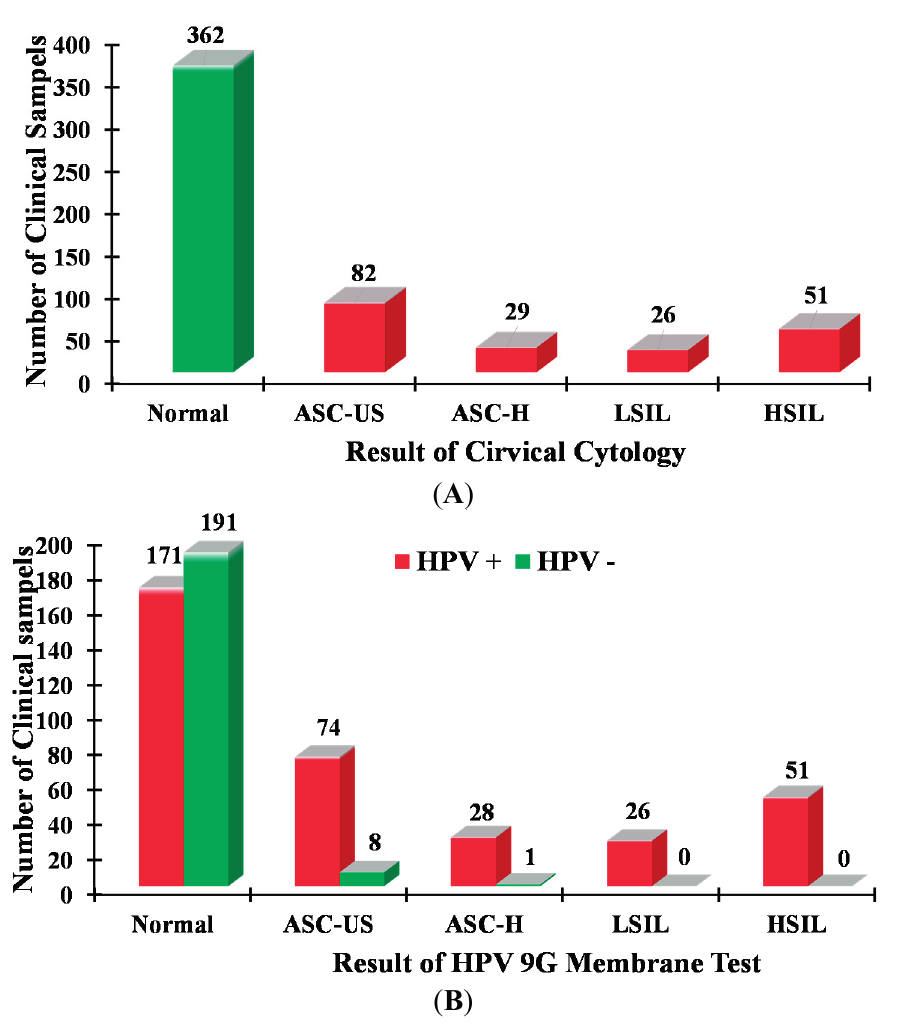
Figure 1. Identification of HPV infected samples. ( A ) Results of cervical cytology; ( B ) results of sequencing analysis and the HPV genotyping 9G membrane test (both results are in 100% agreement with each